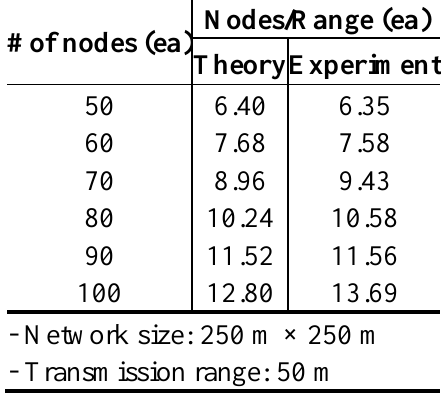
Table 3. Theoretical node density (nodes/range) vs. Experimental node density.